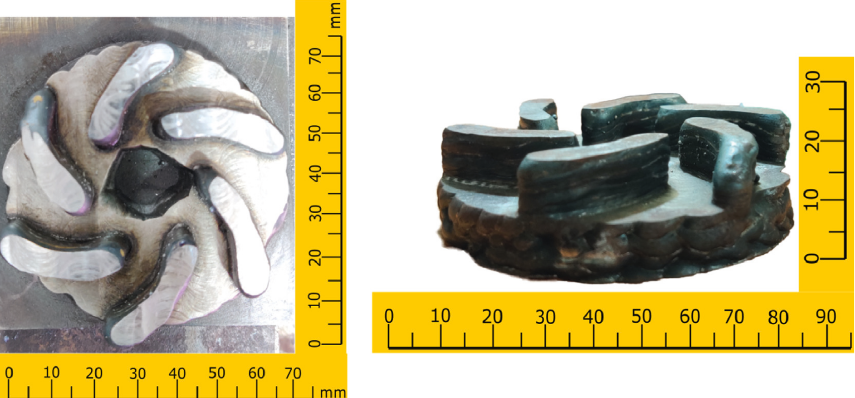
Figure 18: Impeller realized through reusable substrate method.